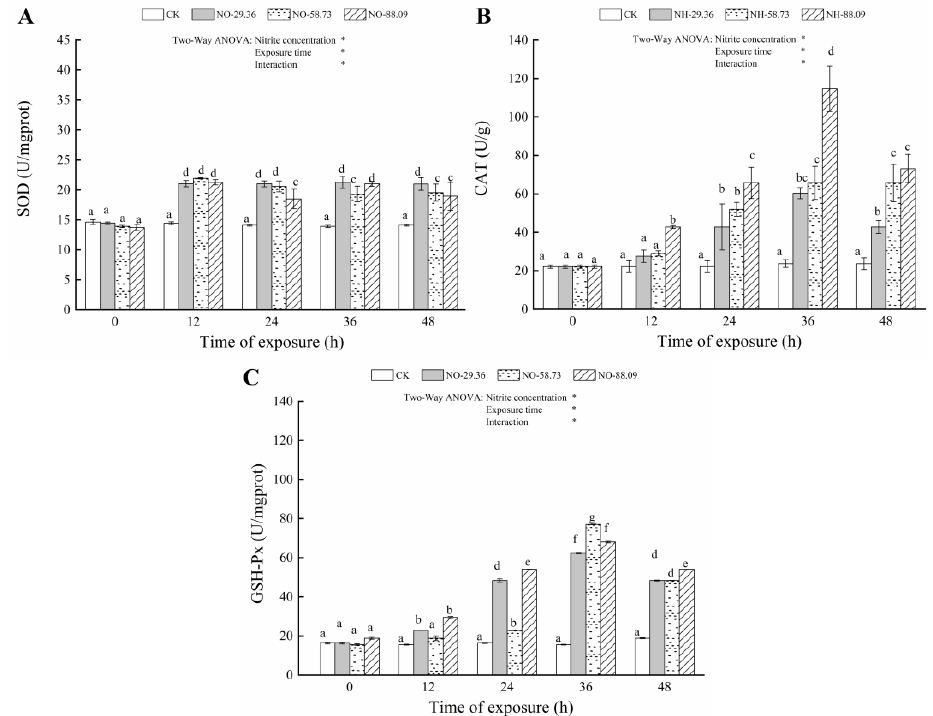
Figure 3. Changes in superoxide dismutase (SOD) ( A ), catalase (CAT) ( B ), and glutathione peroxidase (GSH-Px) ( C ) levels in the gill of large yellow croaker exposed to nitrite at 29.36 mg/L (NO-29.36), 58.73 mg/L (NO-58.73), 88.09 mg/L (NO-88.09), and 0 mg/L (CK) for 48 h. Values are expressed as the mean ± SD. Different lowercase letters indicate significant differences ( p < 0.05) among groups. The CK nitrite group served as the control. * p < 0.05.